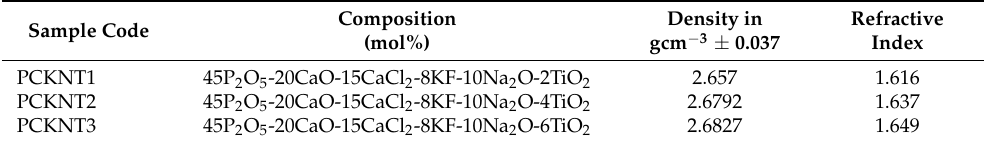
Table 1. The composition, density ( ρ ), and refractive index ( n ) of the PCKNT glass system. Sample